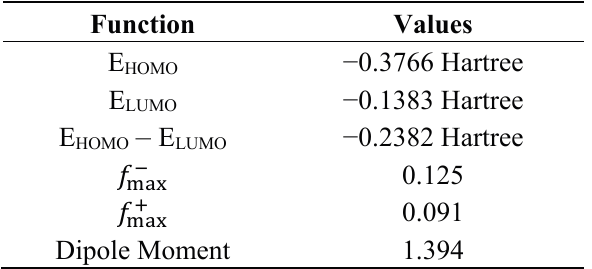
Table 2. Calculated Quantum Chemical Properties for the Most Stable Conformation of